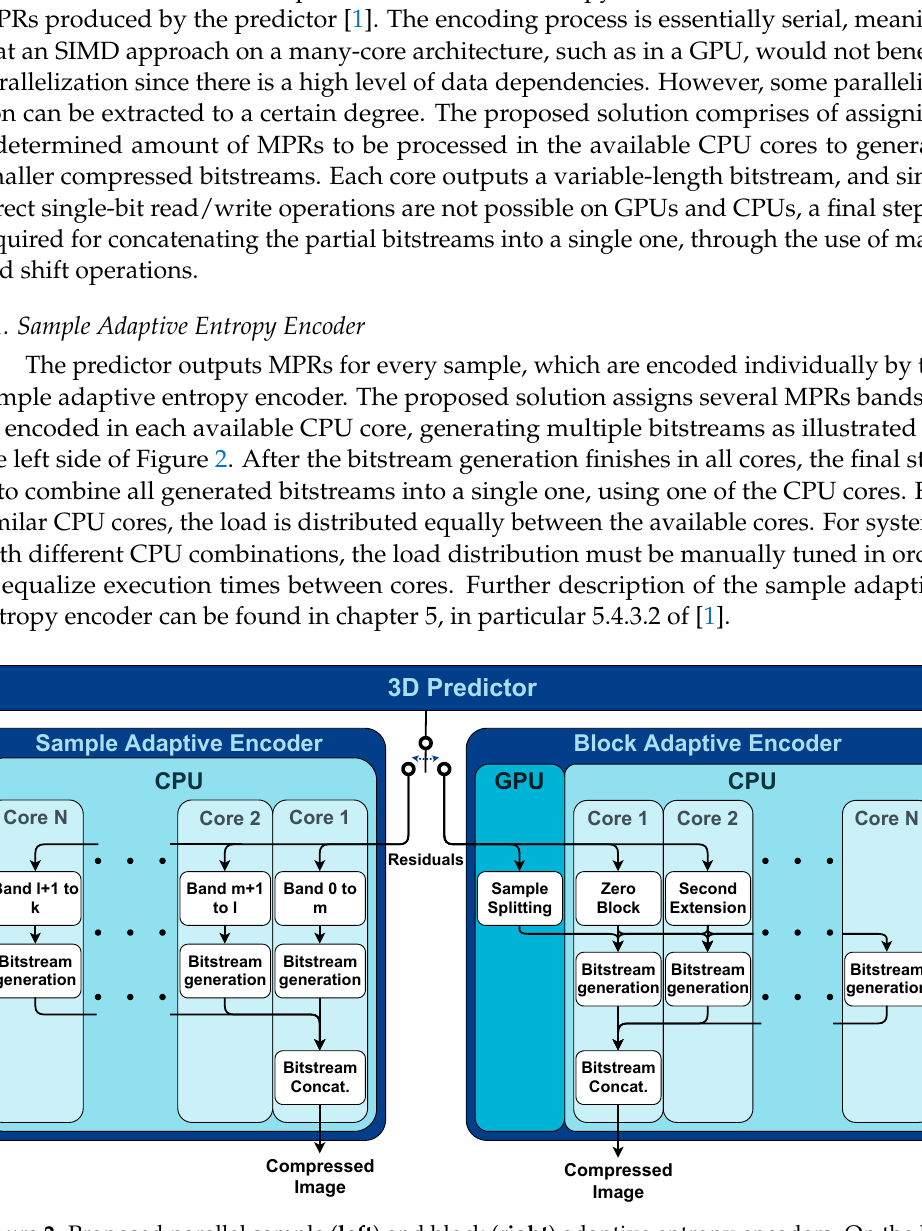
Figure 2. Proposed parallel sample ( left ) and block ( right ) adaptive entropy encoders. On the left side, a determined number of mapped prediction residual (MPR) bands is assigned to each core producing bitstreams. The final step consists of concatenating the bitstreams into one. The right side encodes blocks of MPRs and includes a pre-processing stage of three methods, applying each one to every block to choose the best-compressed one. These methods run concurrently on the GPU and CPU and result in a faster encoding